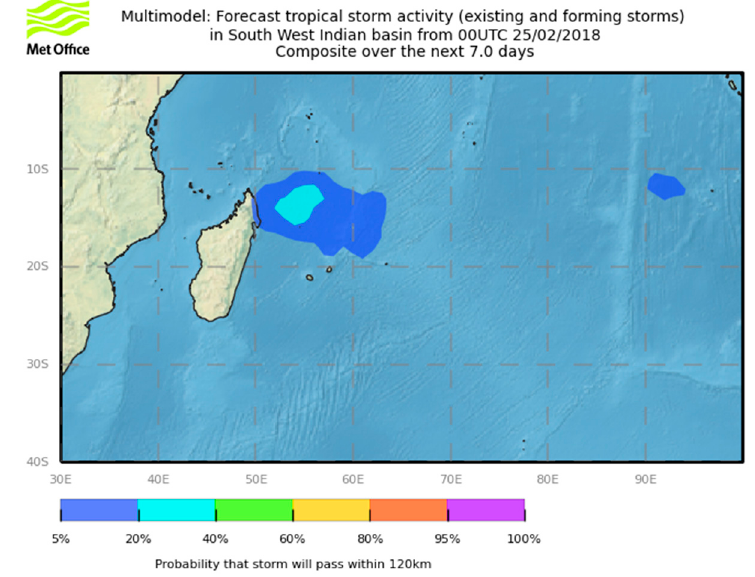
Figure 17. Multi-model ensemble tropical storm strike probability forecast from 25 February for the southwest Indian Ocean basin based on the ECMWF ensemble prediction system (ENS), National Center for Environmental Prediction Global Ensemble Forecast System, (NCEP GEFS) and Met Office MOGREPS-G ensembles (all initialized at 00UTC). The plot shows a composite over the next seven days, and gives an early indication of the formation of what would later become tropical cyclone Dumazile near Madagascar.